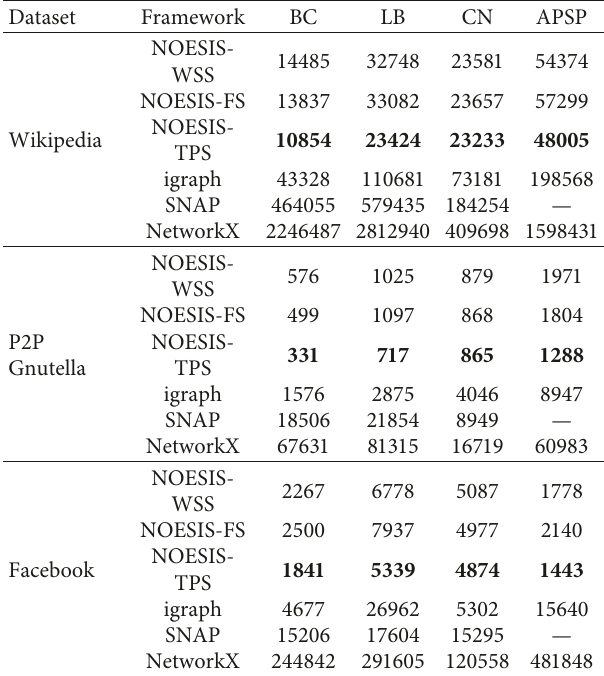
The abbreviations WSS, FS, TPS, BC, LB, CN, and APSP stand for the work- stealing scheduler, future scheduler, thread pool scheduler, betweenness centrality, link betweenness, closeness, and all-pairs shortest paths, re- spectively. Best times for each dataset are shown in